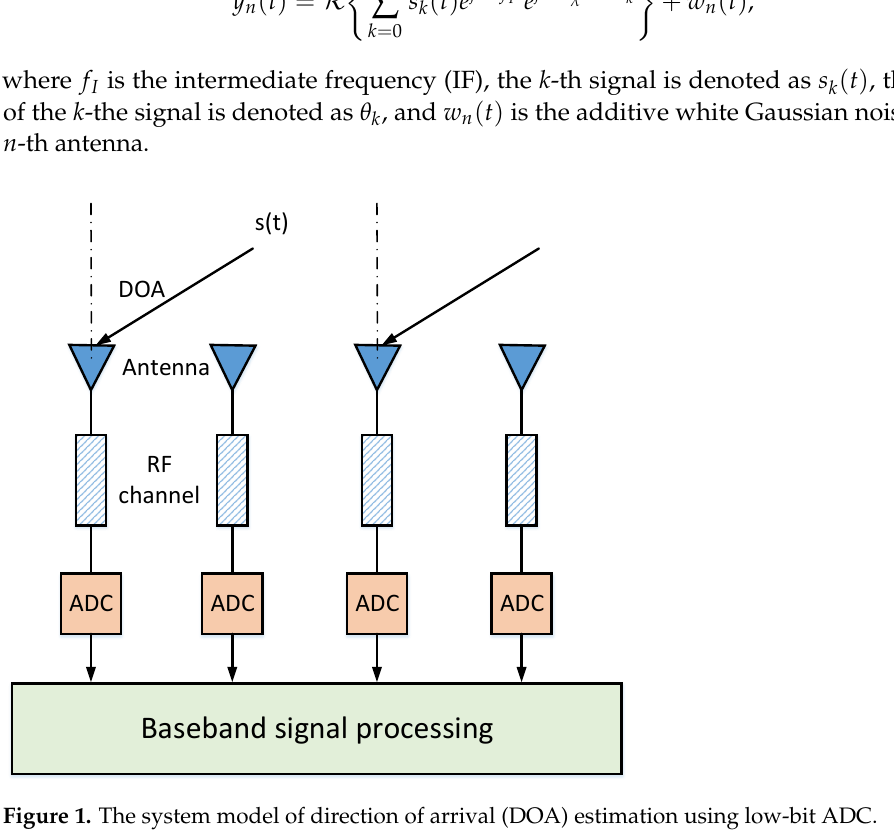
Figure 1. The system model of direction of arrival (DOA) estimation using low-bit